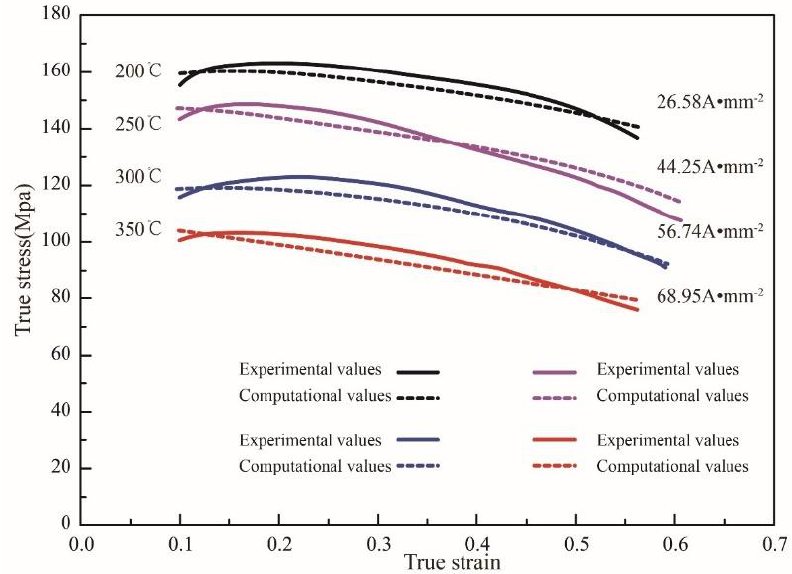
Figure 11. Comparison between calculated values and experimental values of flow stress.